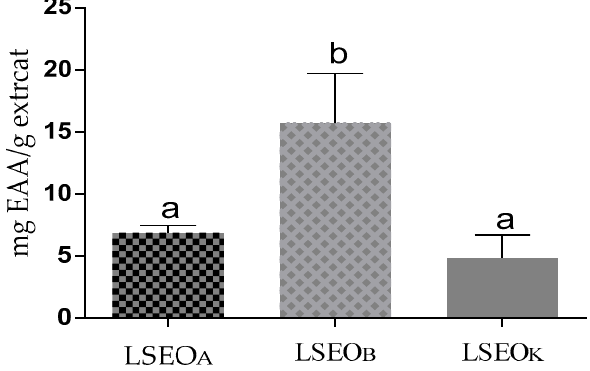
Figure 2. Ferric reducing antioxidant power of LSEO A , LSEO B , and LSEO K in mg of equivalent ascorbic acid/g of extract (values not sharing a common letter differ significantly at p < 0.05).